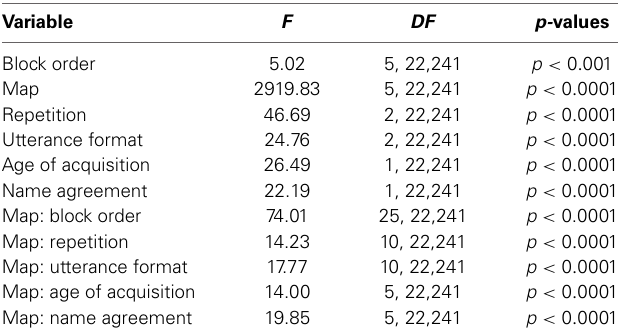
Table 3 | Summary of mixed-effects regression model for